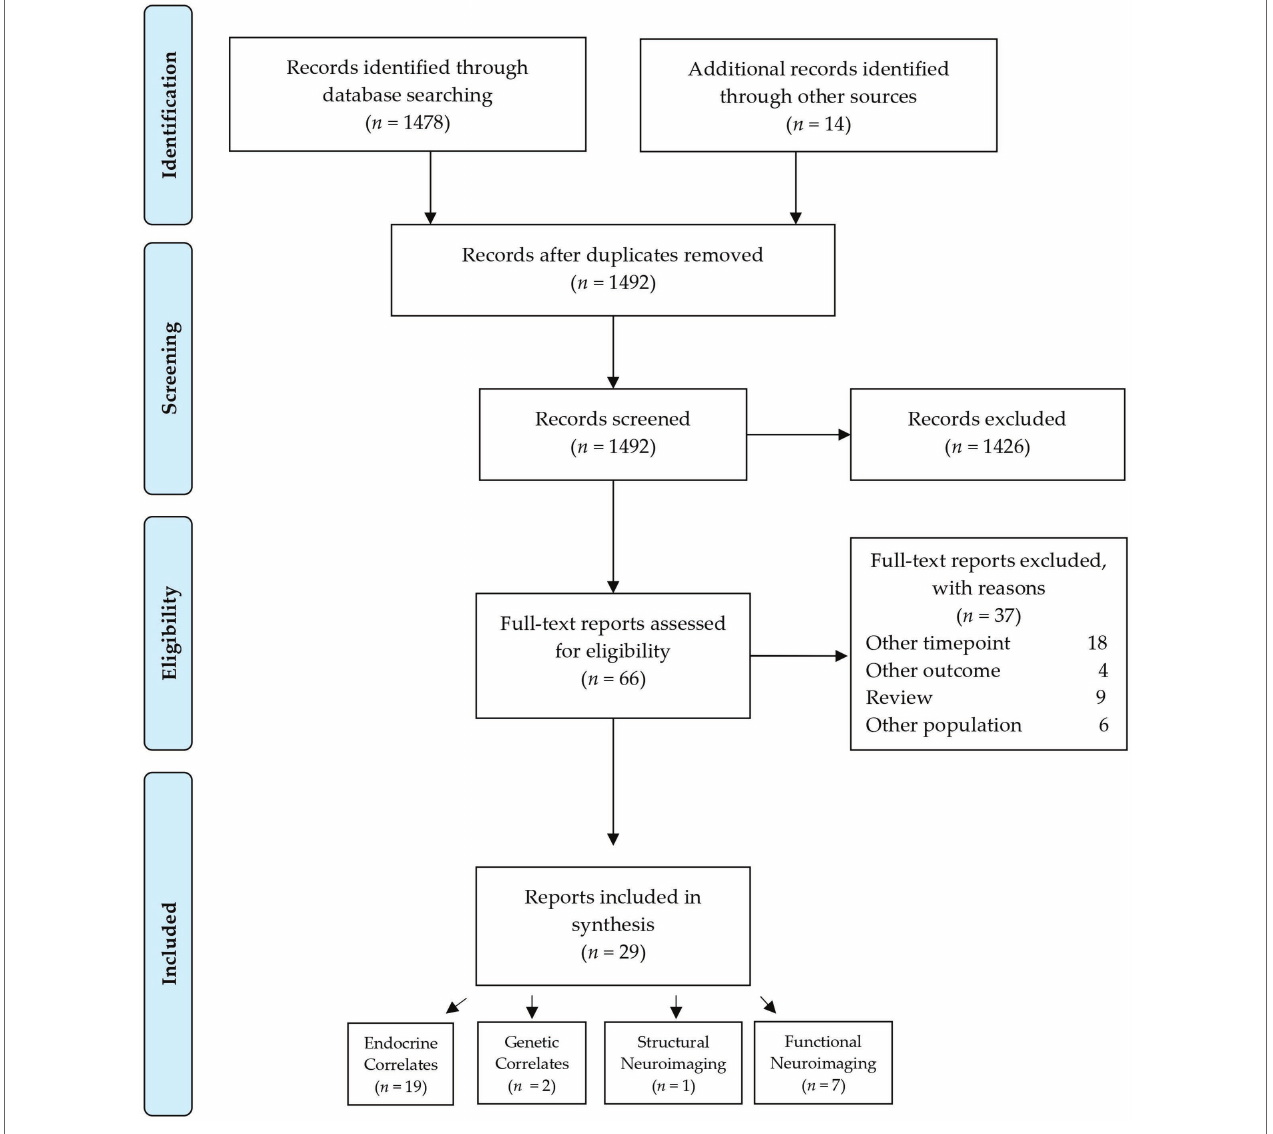
FIGURE 1 | Flow chart of the selection of sources of